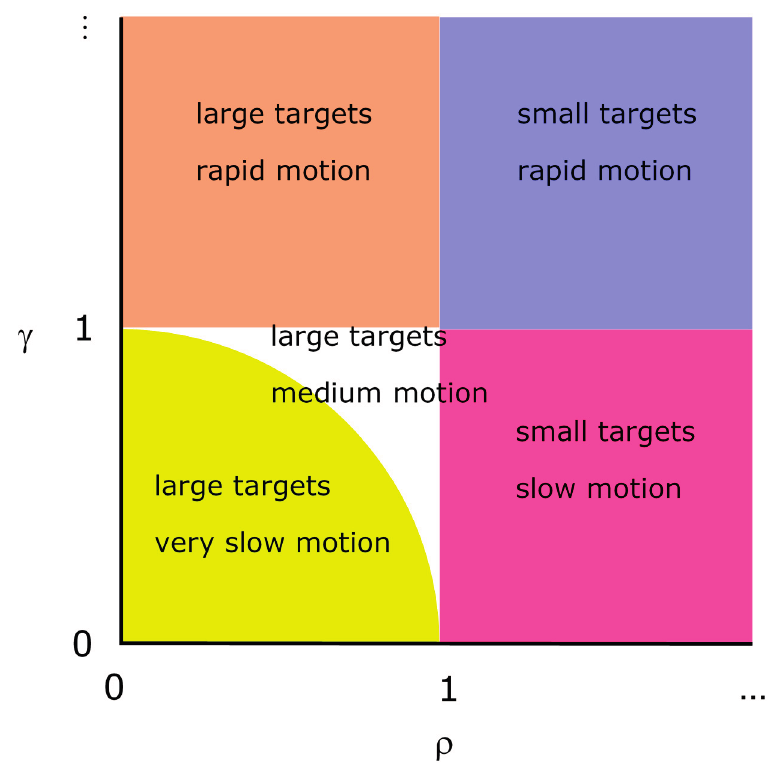
Figure 3. The five regions of parameter space, ρ , γ which define target